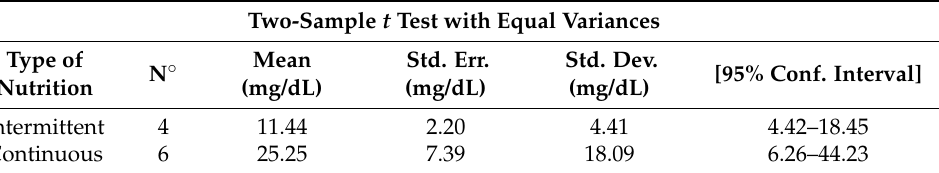
Table 2. Comparison of MAGE in the intermittent versus continuous feeding group. GV was measured by means of EasyGV software. p = 0.1798. Two-Sample t Test with Equal Variances